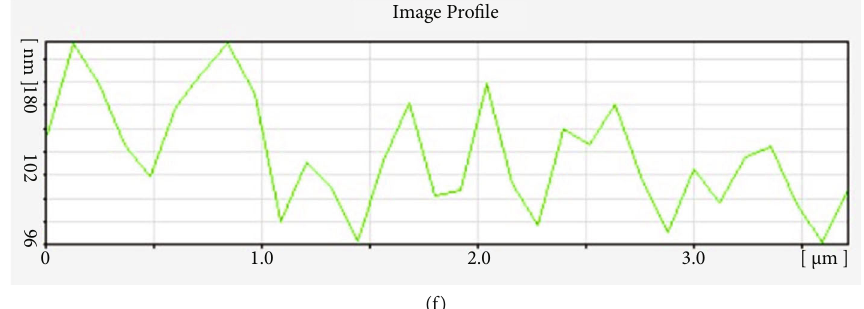
Figure 12: AFM images of PUr-NGQD: (a) and (b) 3D scheme, (c) and (d) 2D images, (e) height distribution plot, and (f) height pro fi le. Table 3: AFM analysis data of PUr and PUr-NGQD nanocomposites.